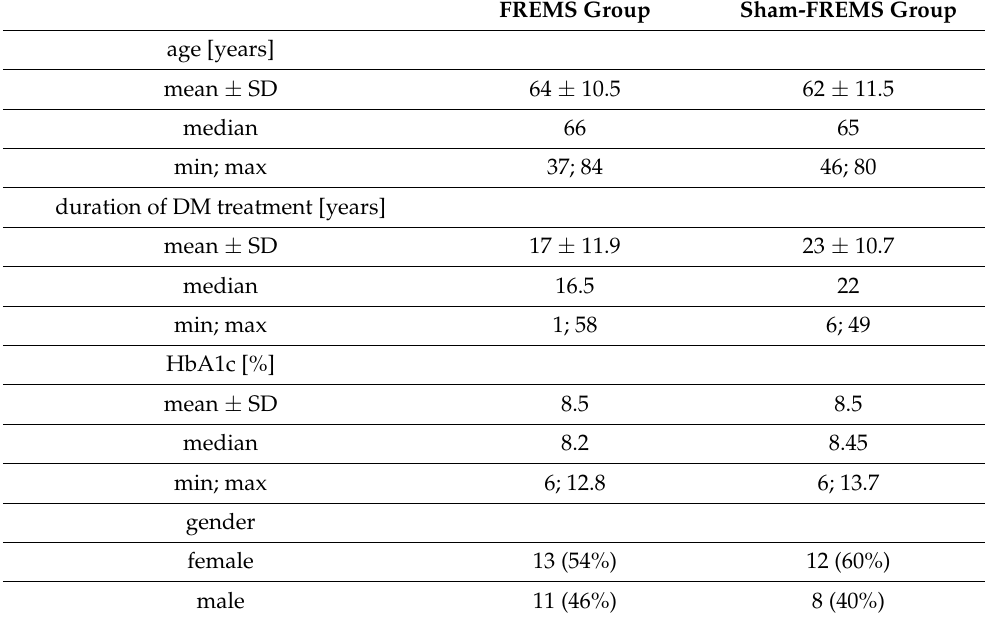
Table 2. Baseline characteristics of the study